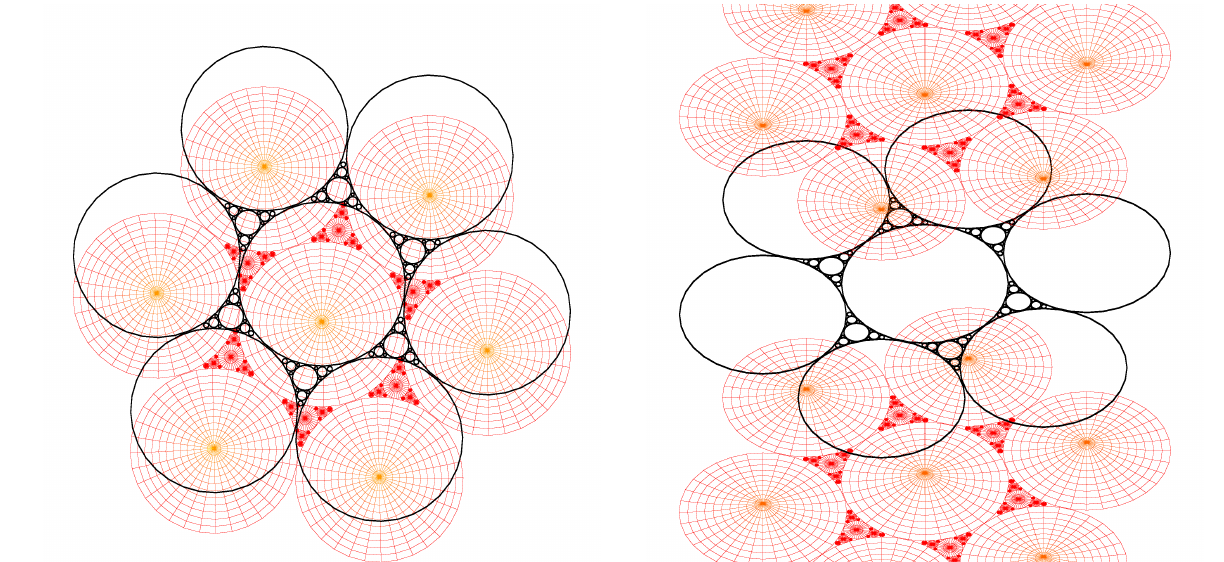
Figure 10. (a): simulation of the smectic layers for one single value of µ ( µ = 3 ) corre- sponding to layers of type 3 with two sheets (only one sheet is visible with this point of view); R = 0 . 9 , θ = 10 ◦ , ϕ = 80 ◦ ; (b): the same simulation with another point of view ( θ = 45 ◦ , ϕ = 45 ◦ ).